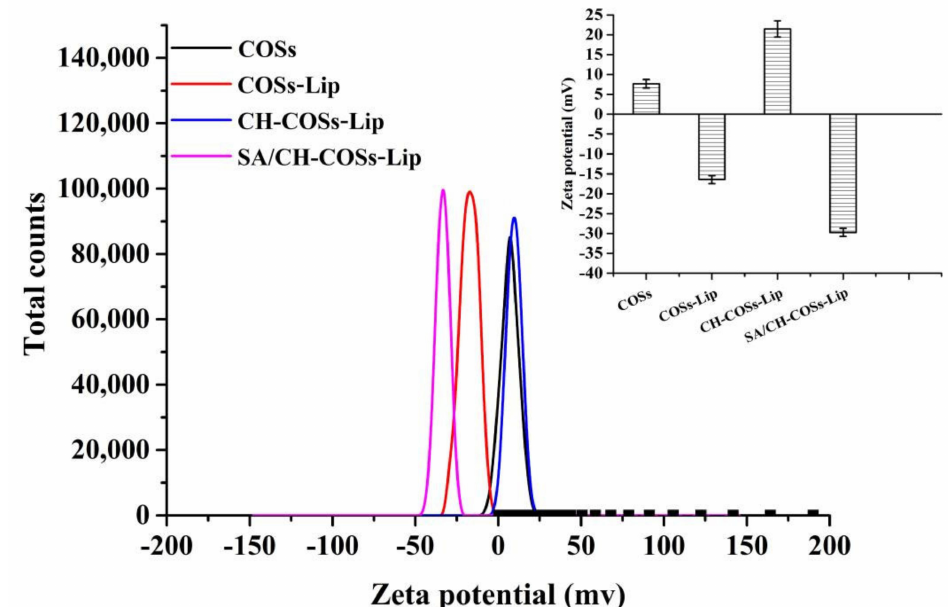
Figure 3. ξ -potential of COSs and COSs nano-liposomes.